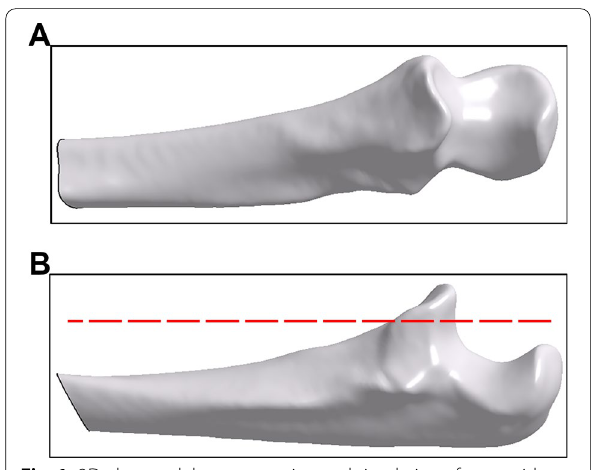
Fig. 1 3D ulna model reconstruction and simulation of coronoid process fracture. A A 3D model of the ulna was reconstructed based on CT images. B A cutting plane ( dashed red line ) trimmed the upper 40% of the coronoid process for the simulation of coronoid process fracture, and the upper segment was used as the model when designing the coronoid